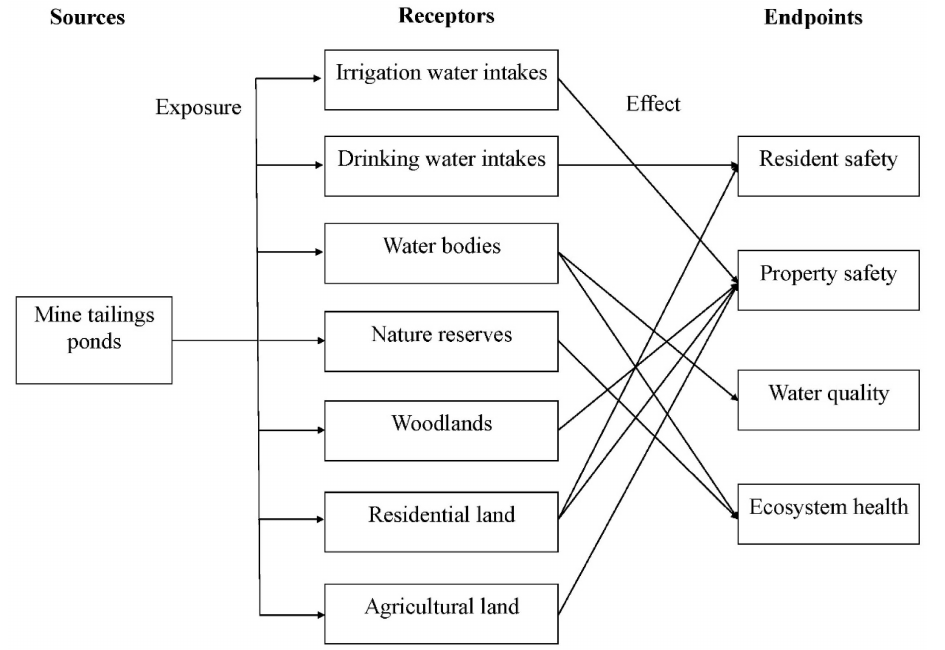
Figure 1. Combination of Risk Routes; adapted from Liu et al.